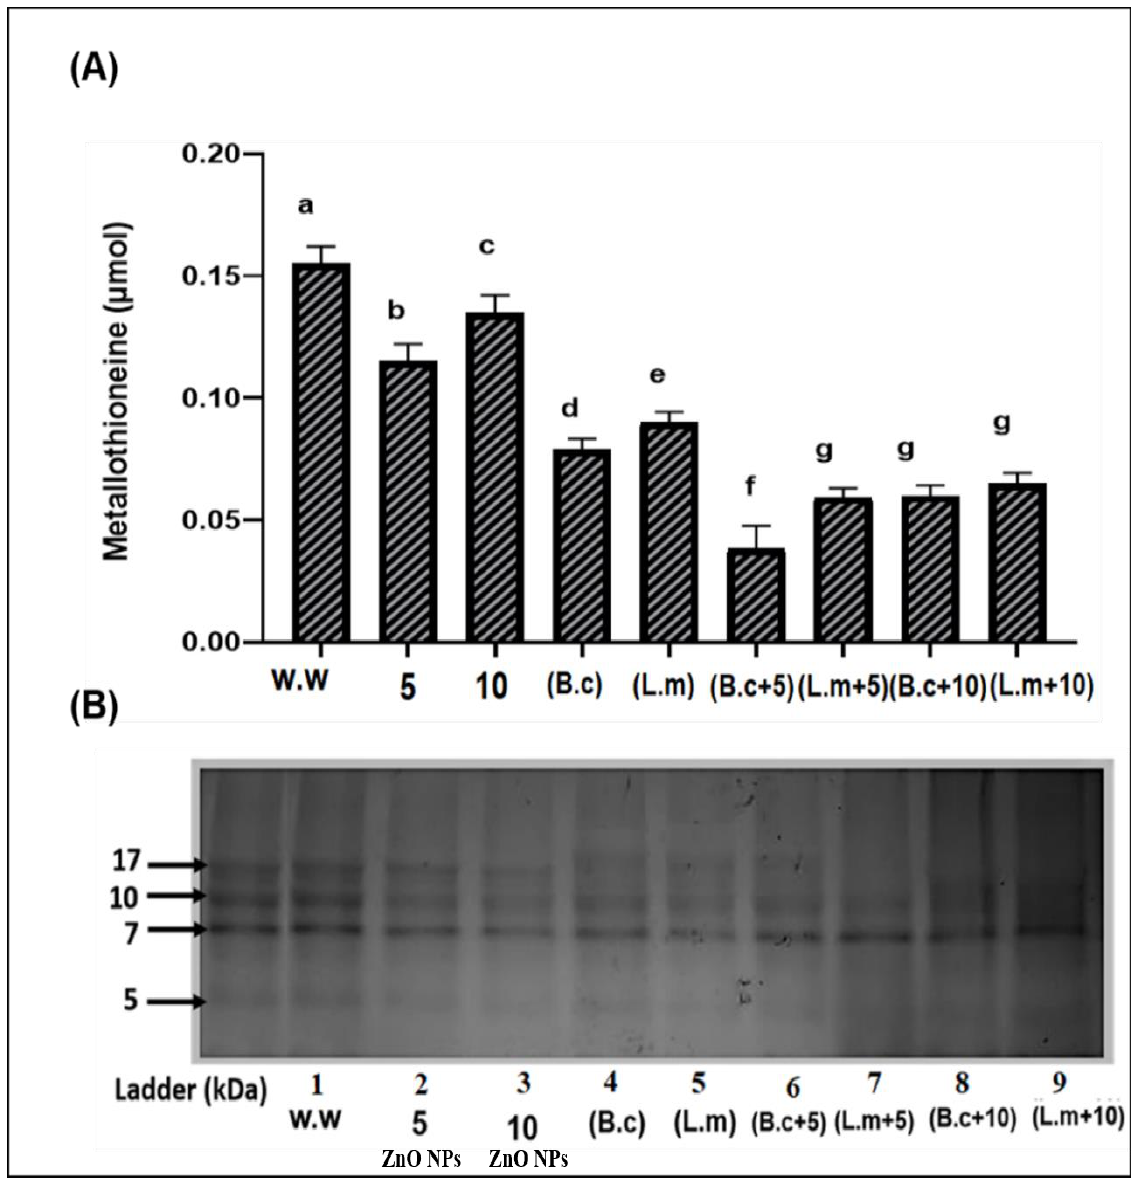
Figure 6. Synergistic effect of the bacterial strains ( B. cereus and L. macroides ) and ZnO NPs (5 and 10 mg/L) on Metallothioneins (MTs) contents ( A ) and concentration ( B ) of rice plants grown in HMs contaminated water. Lane 1: w.w (Waste water)., Lane 2: 5 mg/L ZnO NPs + w.w., Lane 3: 10 mg/L ZnO NPs + w.w., Lane 4: B.c +w.w, Lane 5: L.m + w.w., Lane 6: B.c. + 5 ( B. cereus + 5 mg/L ZnO NPs + w.w.)., and Lane 7: L.m + 5 ( L. macroides + 5 mg/L ZnONPs + w.w.), Lane 8: B.c. + 10 ( B. cereus + 10 mg/L ZnO NPs +w.w.) and Lane 9: L.m. + 10 ( L. macroides + 10 mg/L ZnO NPs + w.w.). Error bars show means of standard error ( ± S.E.) of three replicates ( n = 3) showing statistical significance at 5% probability level (ANOVA). Different alphabets appeared in superscript on each number showed statistically significant at 5% probability